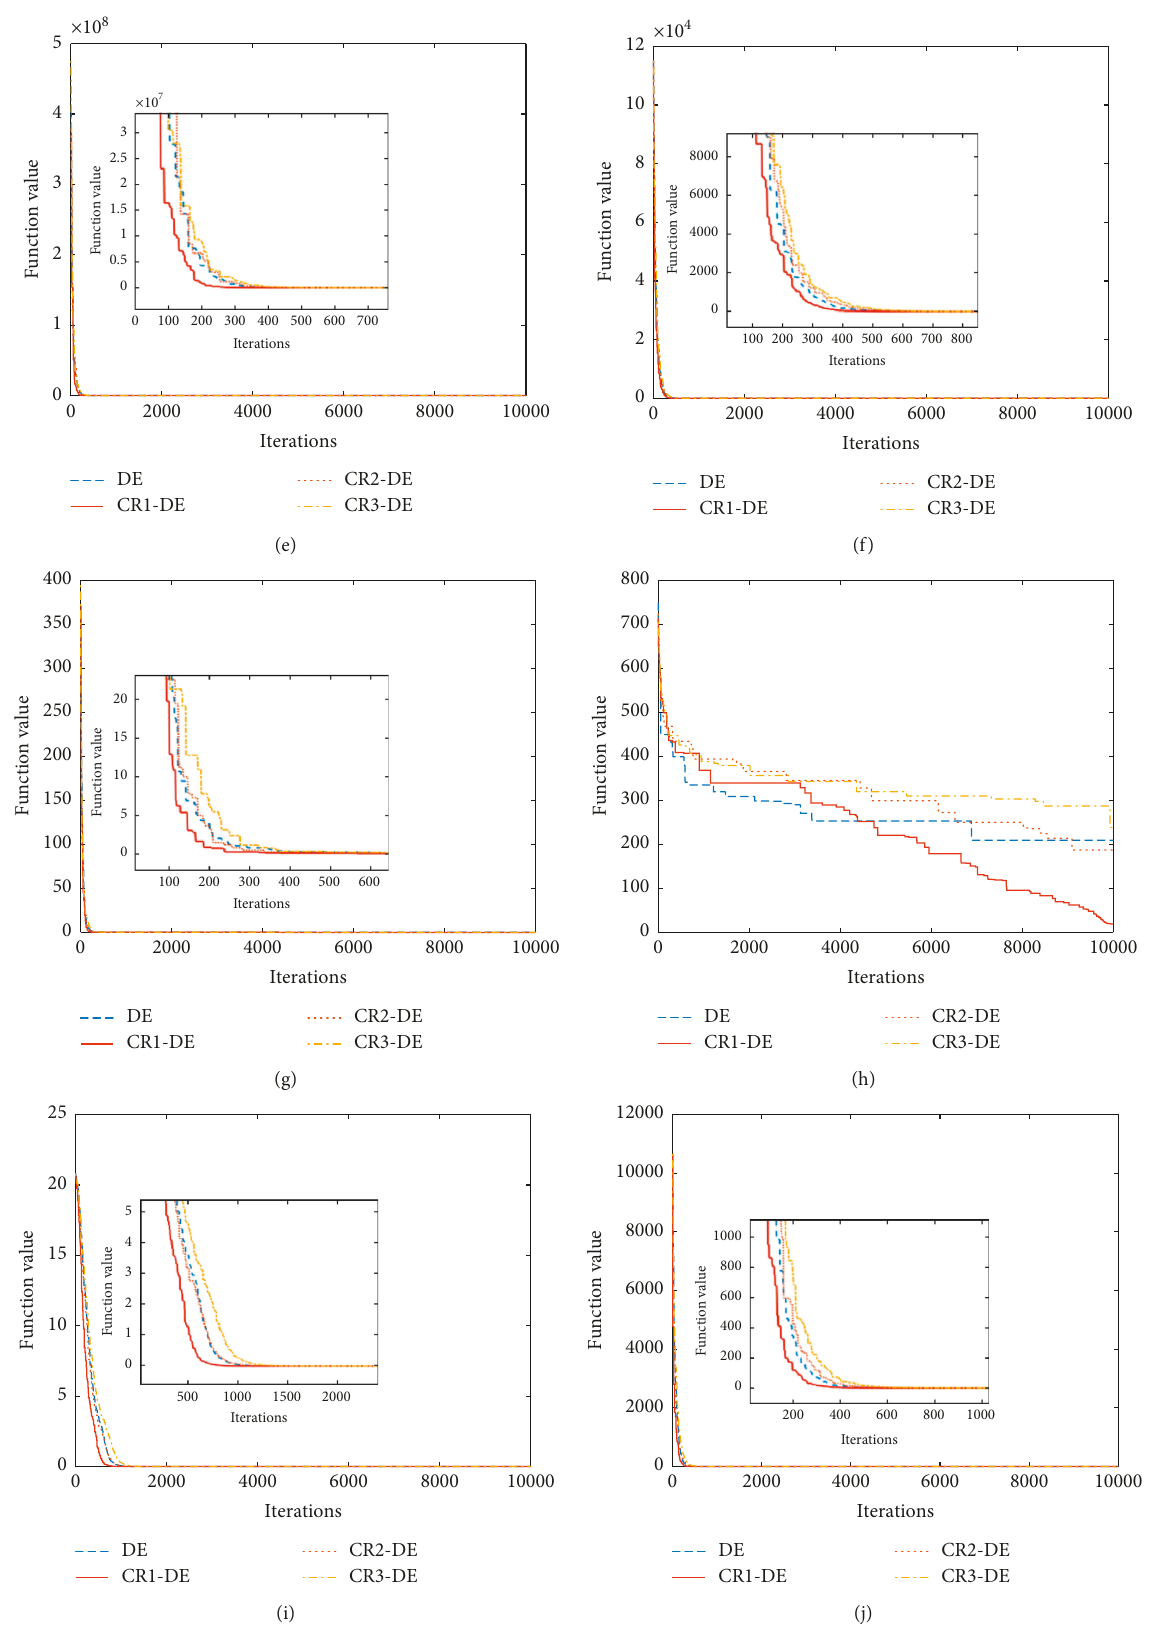
Figure 5: Convergence curves of f � 50 (if there are two figures in one subgraph, the smaller one represents partial enlarged 1 – f 10 when D drawing of the bigger one for clear presentation). (a) f 1 , (b) f 2 , (c) f 3 , (d) f 4 , (e) f 5 , (f) f 6 , (g) f 7 , (h) f 8 , (i) f 9 , and (j) f 10